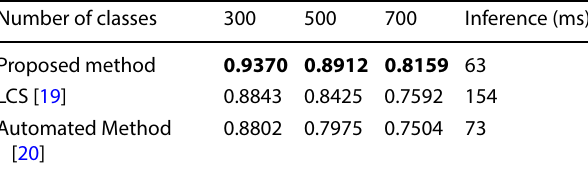
Table 1 Accuracy and inference time of the proposed classification against two state of the art methods